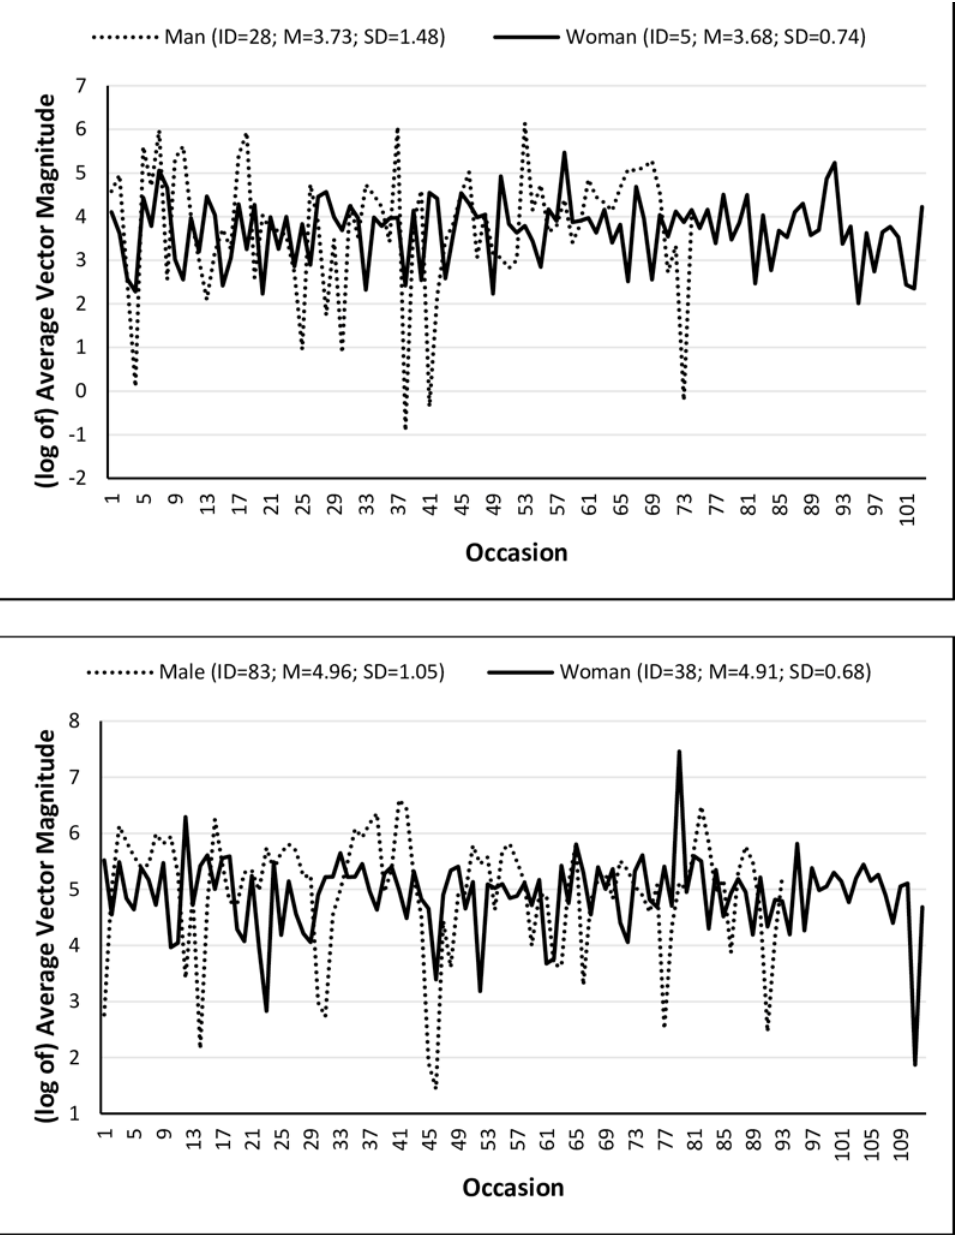
Fig 3. Between-Sex and Between-AD Status Differences in the Variability of Physical Activity Across Occasions. Man and woman with mild AD (top) and a healthy man and woman